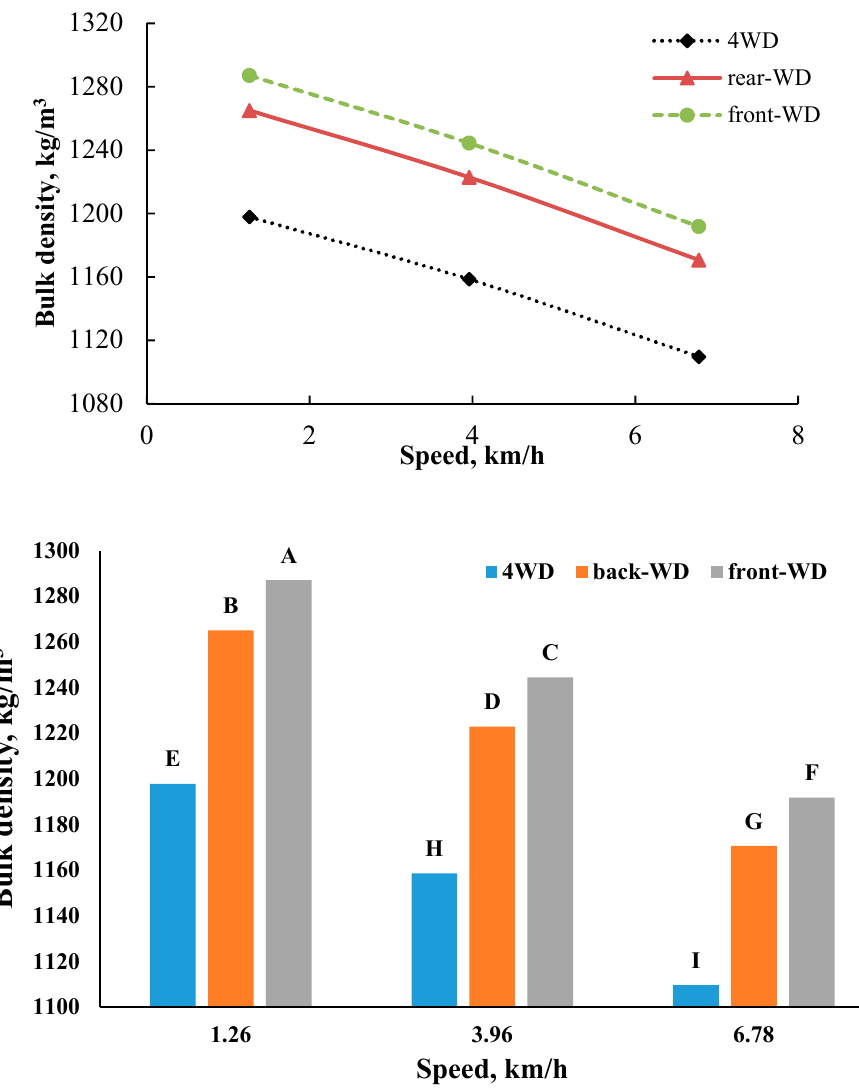
Figure 6. Effects of the drive system on soil compaction at three tractor forward speeds (different letters shows significant difference between treatments).